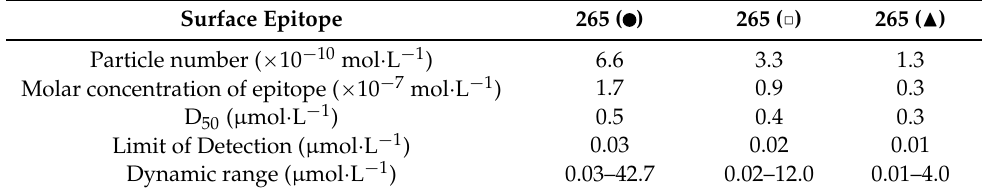
Table 1. Displacement assay parameters derived from Figure 3.